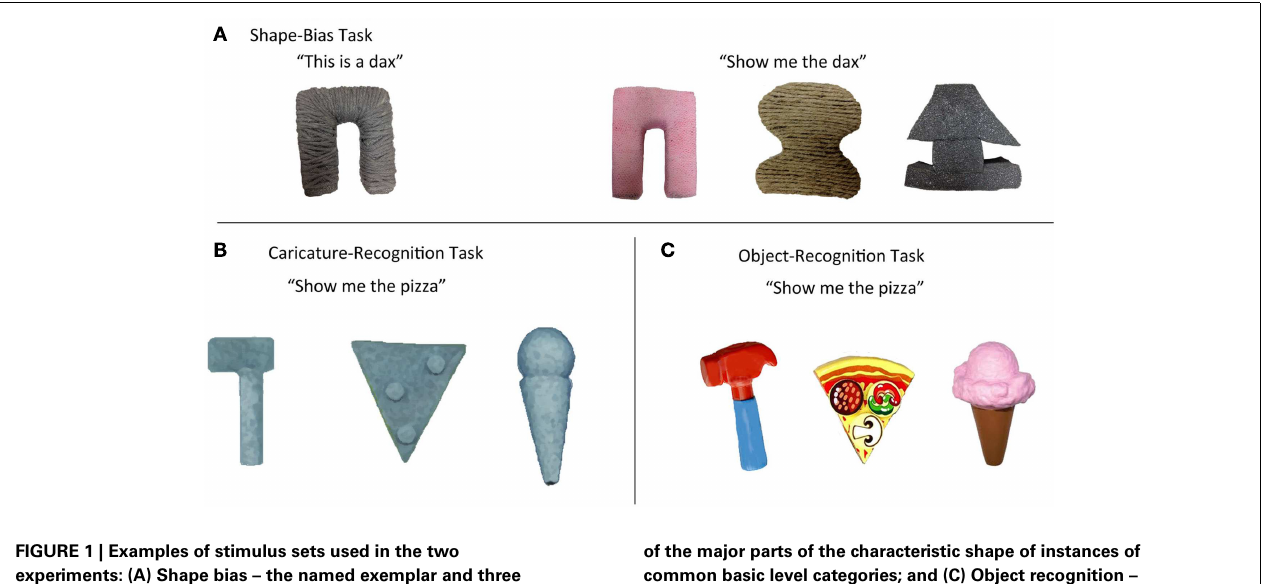
FIGURE 1 | Examples of stimulus sets used in the two experiments: (A) Shape bias – the named exemplar and three test objects matching in shape, surface texture, and color; (B) Caricature recognition – three sparse structural representations